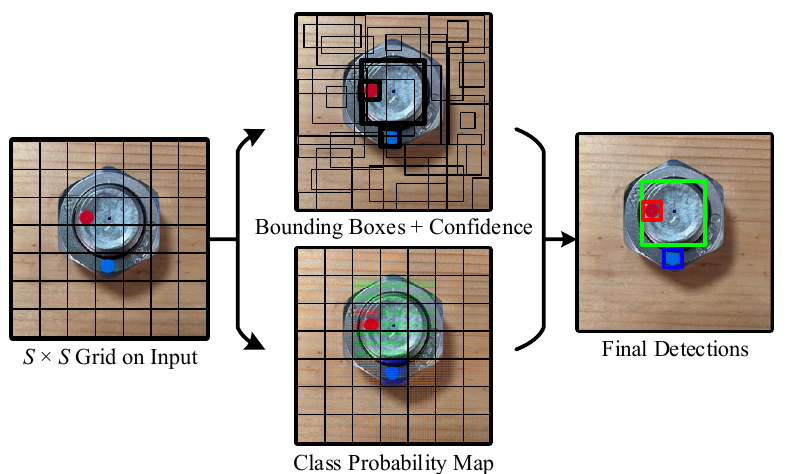
Figure 2. The principle of target detection using YOLO.